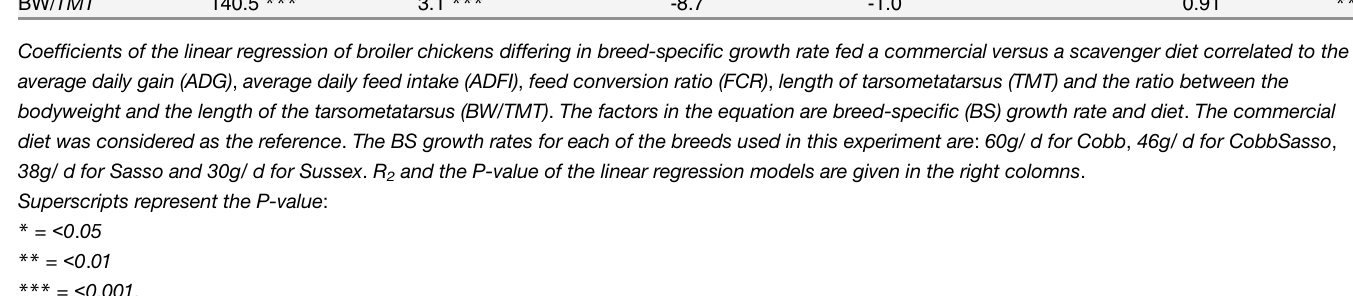
Feed intake The ADFI was significantly higher for the scavenger diet ( P < 0.001) and with increasing breed-specific growth rate ( P < 0.001). No significant interaction between breed-specific growth rate and diet on the ADFI was found ( P > 0.05) Table 2 (Fig 3).